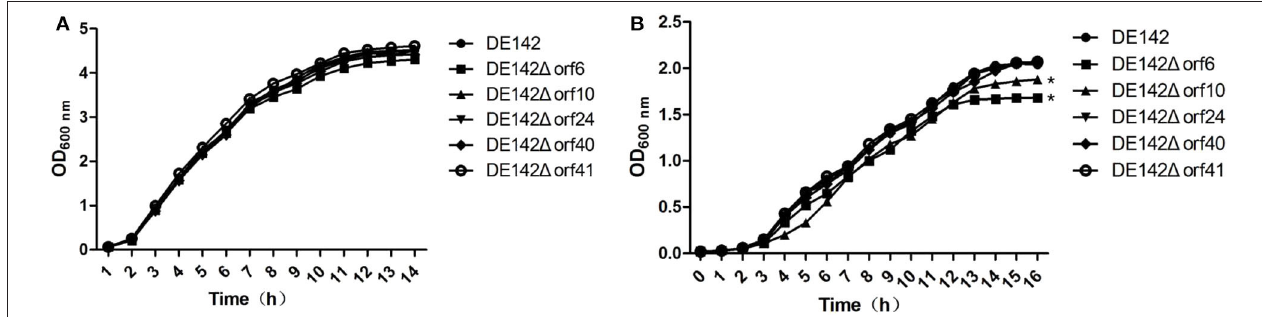
FIGURE 1 | Growth curve of different strains. (A) Growth curves of the wild-type strain DE142 and its derivative mutant strains in LB broth. (B) Growth curves of the wild-type strain DE142 and its derivative mutant strains in SPF chicken serum. Values were the average of three independent experiments (* P < 0.05 by unpaired t -test).